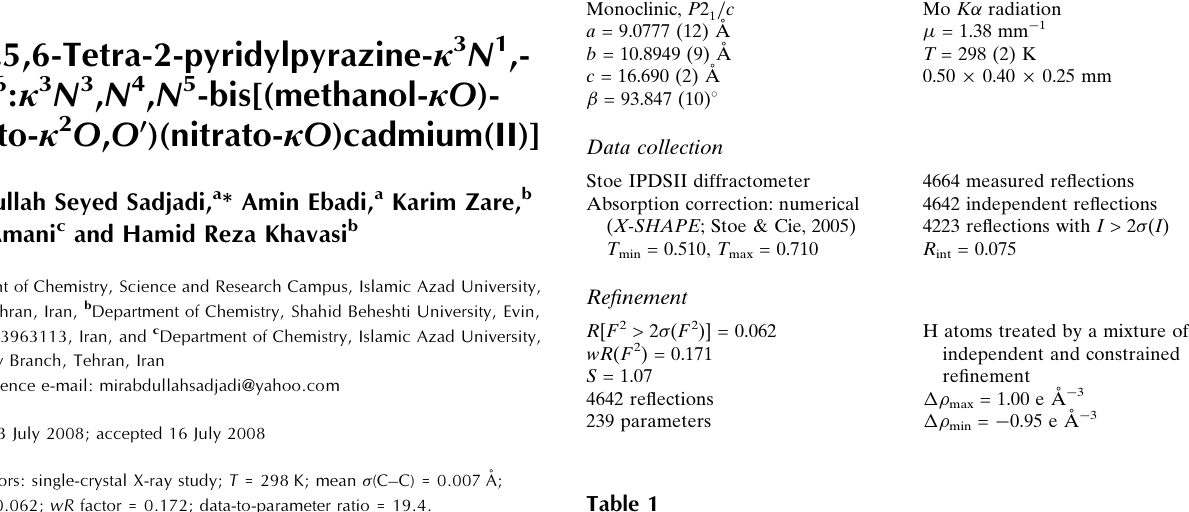
Selected geometric parameters (A˚ , (cid:1) ).